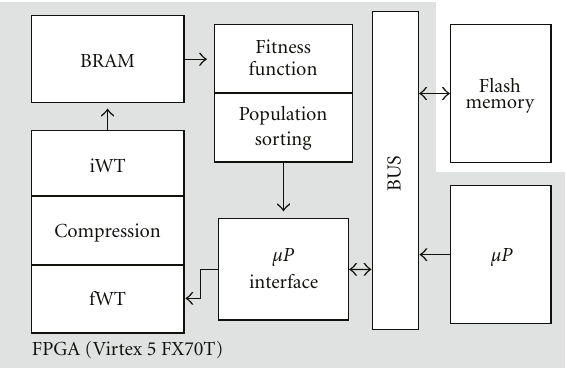
Figure 18: System level architecture.